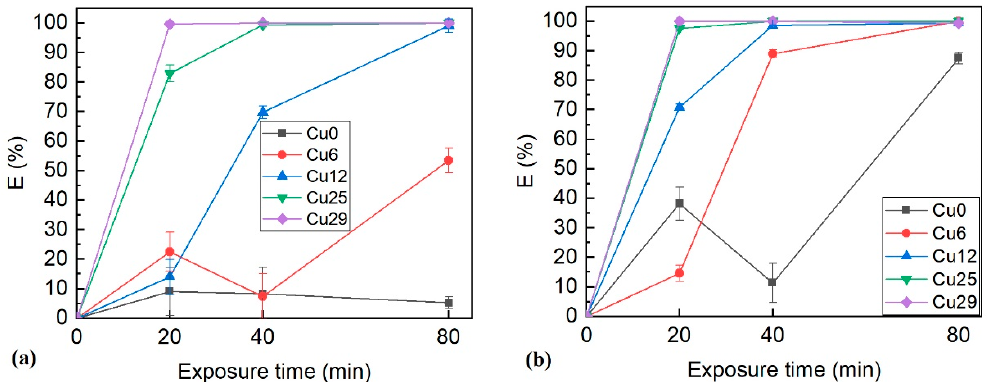
Figure 8. Bactericidal efficiency of ZrN-Cu coatings against ( a ) E. coli ; ( b ) P. aeruginosa at different exposure times.